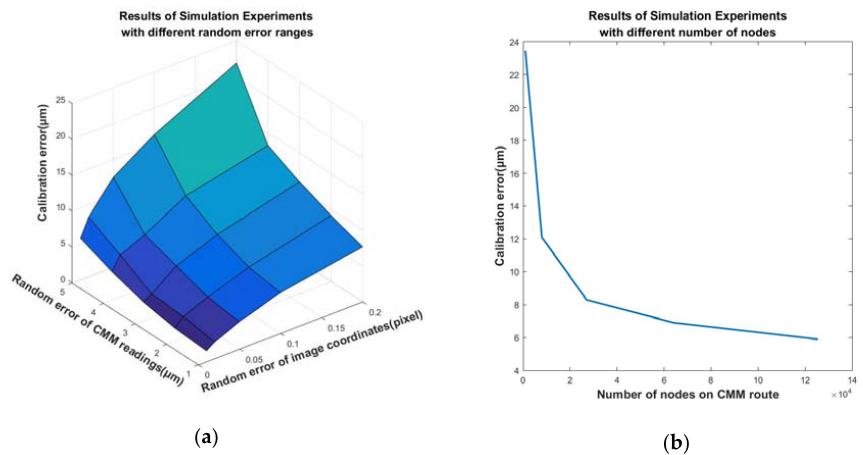
Figure 5. Calibration results of simulation experiments: ( a ) Calibration errors with different ranges of random errors. The random errors obey normal distribution, and the scale values are different standard deviations. ( b ) Calibration errors with different numbers of nodes on the CMM route.